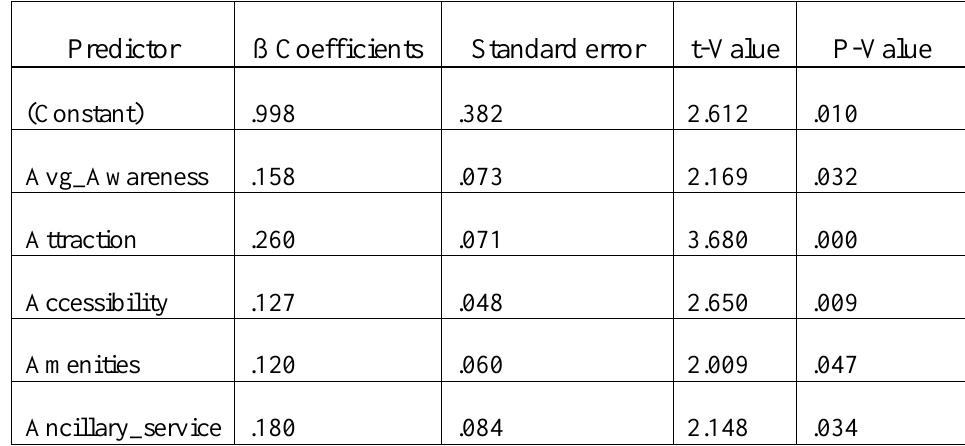
Table 4 - Multiple Regression